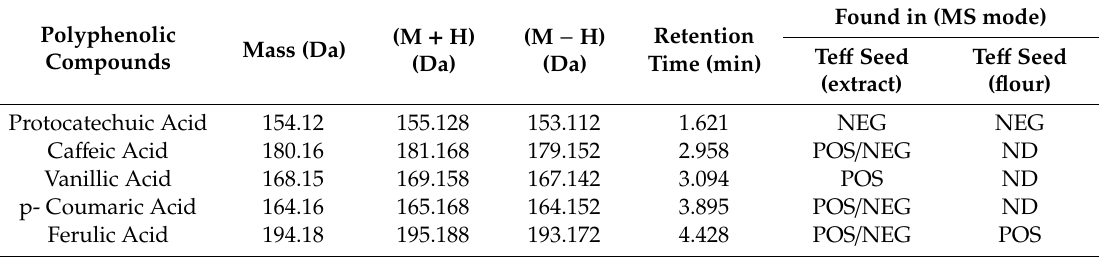
Table 4. Concentration of the five most common polyphenolic compounds in te ff samples 1